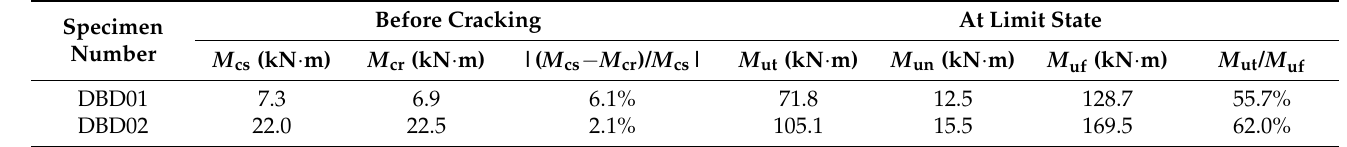
Table 5. Composite working performance of sandwich laminated floor